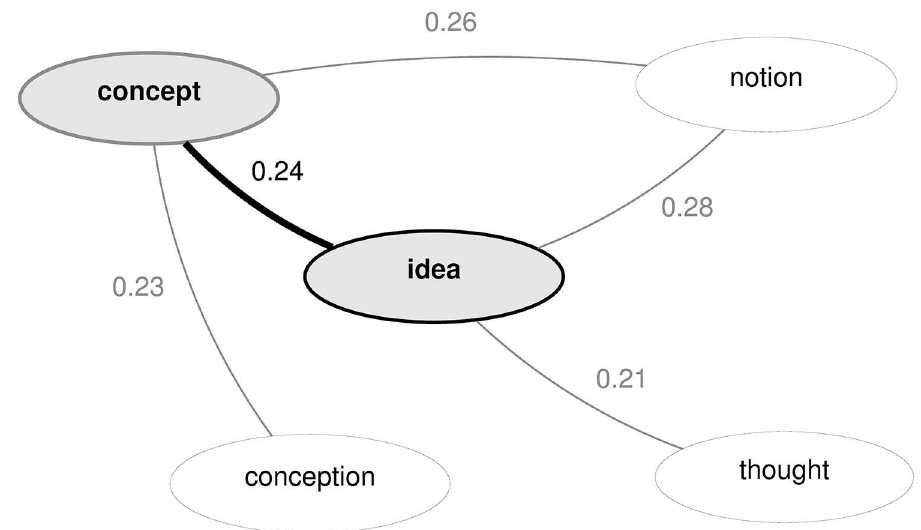
Fig 4. Word pairwise similarity data visualised as an edge-weighted graph. Nodes correspondto words and edges are weightedby similarity scores (for any score >